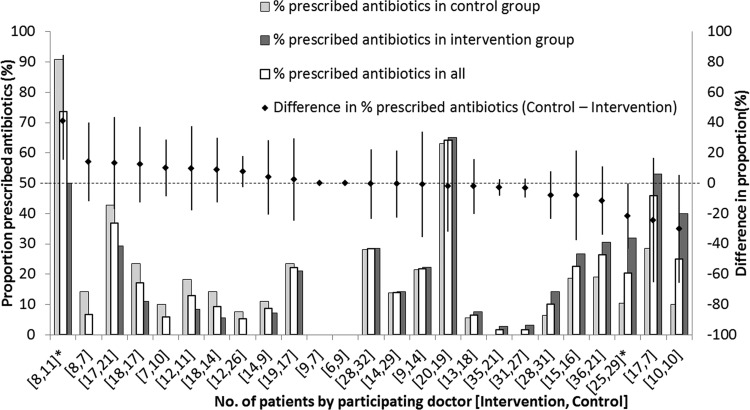
Proportion of patients that were prescribed antibiotics in intervention and control arms, stratified by participating GP. Bars (left vertical axis) represent the percentages of control patients (dark gray), all patients (white with bold outline), and intervention patients (light gray) that were prescribed antibiotics. The diamonds coinciding with the middle bars are the differences in proportion with antibiotic prescriptions between the two arms (control − intervention, with error bars denoting the 95% confidence intervals [right vertical axis]). The numbers of interventions and control arm patients for that GP are in the brackets below the bars; two of the GPs are starred because the difference was statistically significant.